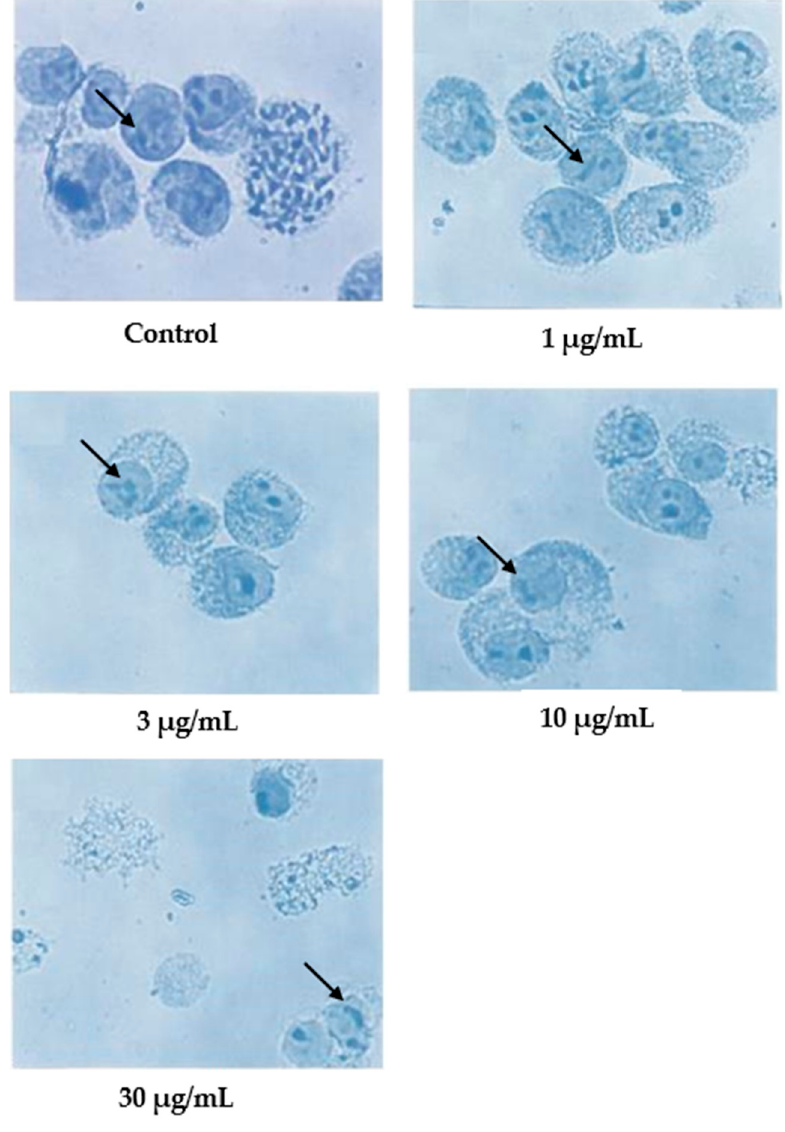
Figure 5. Giemsa-stained CEM-SS cells without treatment (control) or treated with different concen- trations of damnacanthal for 24 h (200 × magnification). Arrows indicate collapsed chromatin.